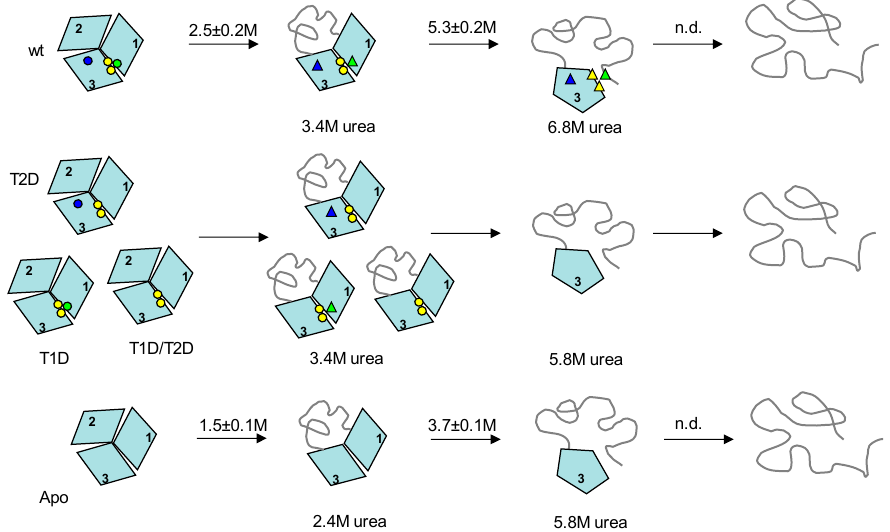
Figure 4. Unfolding pathways of wild-type ( upper scheme), T2D, T1D, T1D/T2D ( center scheme) and apo- ( bottom scheme) Fet3p variants. The apparent transition midpoints (average values from CD and fluorescence measurements, Table S1) for holo- and apo-forms of Fet3p are shown above the arrows (the midpoints for partially-metallated forms were not identified by the individual measurements). Native-like coordination of copper ions is shown as circles, and perturbed copper coordination (but still bound copper) is shown as triangles. The circles and the triangles, in schematically shown structures, indicate locations of T1 (blue), T2 (green), and binuclear T3 (yellow) copper ions.